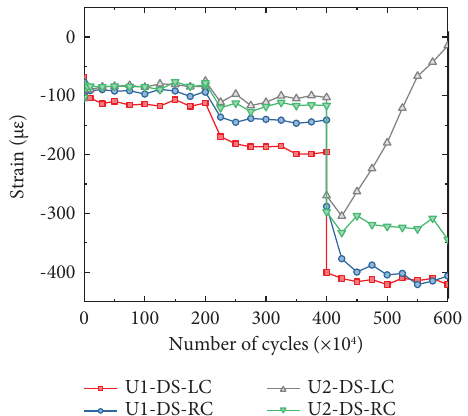
Figure 15: Displacements versus number of cycles.